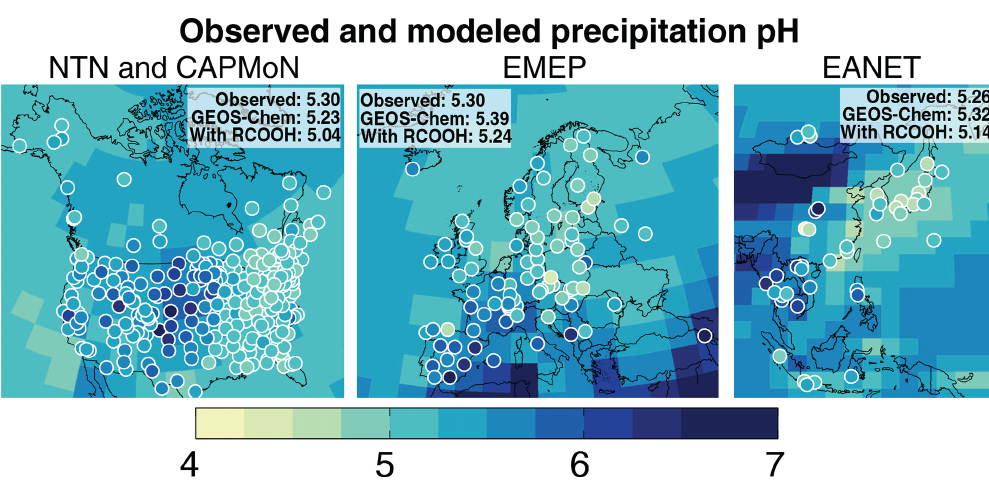
Figure 8. Annual volume-weighted average (VWA) precipitation pH over North America, Europe, and East Asia for the year 2013. Values are the precipitation volume-weighted averages of the monthly means (Eq. 6). The GEOS-Chem model values (solid background) exclude RCOOH (HCOOH and CH 3 COOH) from the pH calculation for the comparison to observations. Observations (circles) are from the US National Trends Network (NTN), the Canadian Air and Precipitation Monitoring Network (CAPMoN), the European Monitoring and Eval- uation Programme (EMEP), and the Acid Deposition Monitoring Network in East Asia (EANET). The EANET sites in Malaysia are not shown because of their different sampling procedure (see text). The insets in each panel show the spatial means of the observations for the corresponding region as well as the corresponding GEOS-Chem means at the measurement locations. The mean GEOS-Chem pH values with RCOOH included in the pH calculations are also